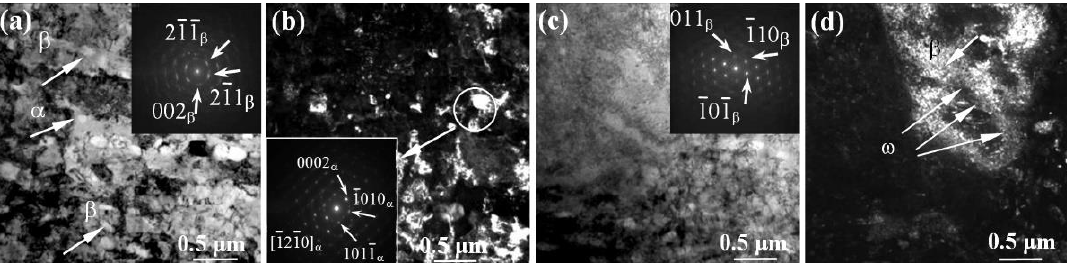
Figure 11. Microstructure of the Ti-45Nb alloy in the UFG state before fracture in the neck area: ( a , c ) — the BF TEM images with the SAD patterns; ( b , d ) — the DF TEM images taken in ( b ) α -phase reflection and ( β + ω )-phase reflection. Fragmented substructure ( a , b ), large anisotropic fragments with a cellular-network dislocation substructure ( c , d ). Arrows show reflections from identified phases and phases.